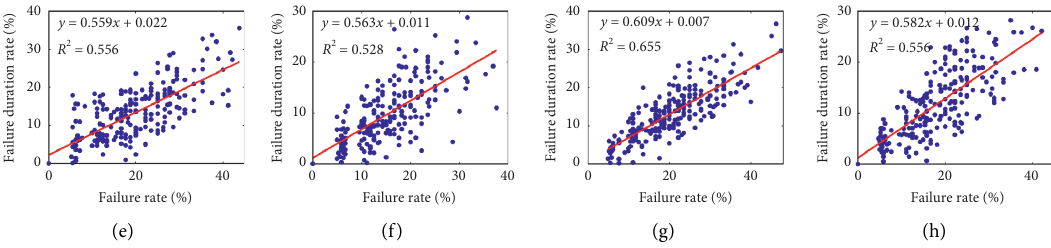
Figure 4: The relationship analysis between FDR vs. FR. (a) No.1 bus stop. (b) No.2 bus stop. (c) No.3 bus stop. (d) No.4 bus stop. (e) No.5 bus stop. (f) No.6 bus stop. (g) No.7 bus stop. (h) No.8 bus stop. Table 3: Failure duration rate of test bus stops at different failure rate levels.